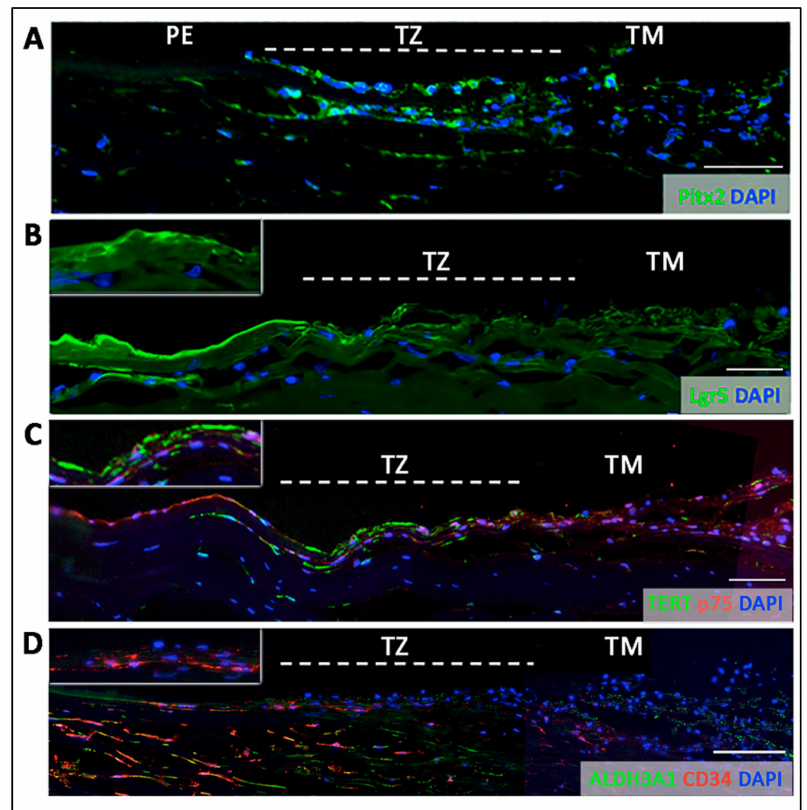
Figure 4. Immunostaining on transverse sections showing the expression of ( A ) nuclear Pitx2 across the entire transition zone (TZ). The stem cell markers, ( B ) Lgr5 on cell surface, ( C ) telomerase (TERT) and ( D ) CD34 were more expressed in the inner TZ. The positive cells were also located in the stroma immediately beneath the TZ surface (insets). ( D ) Quiescent stromal keratocytes co-expressed CD34 and aldehyde dehydrogenase 3A1 (ALDH3A1, a keratocyte marker). White dotted lines delineate TZ location between peripheral endothelium (PE) and trabecular meshwork (TM). Scale bars: 50 µ